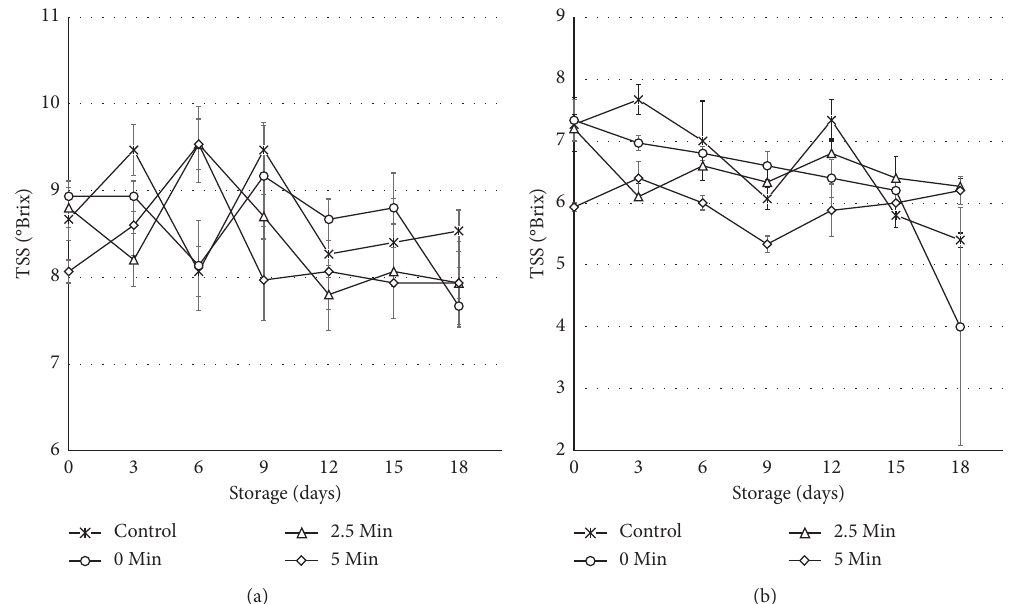
Figure 4: Effect of the immersion time of fresh-cut papaya fruit in NJ on the content of TSS during their storage at 4 ° C. Control (a) and treated with E . coli (b).